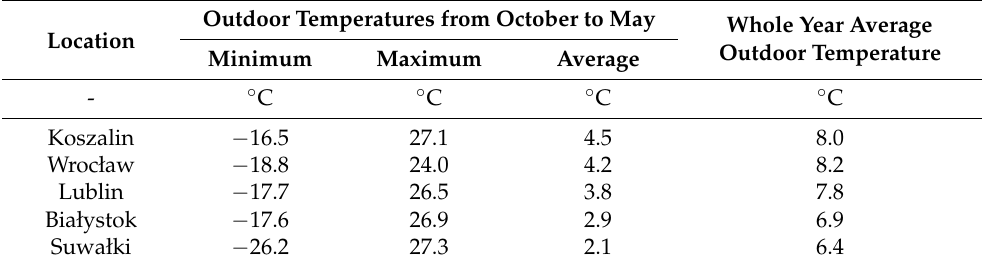
Table 1. Outdoor air temperatures depending on location, based on [50].